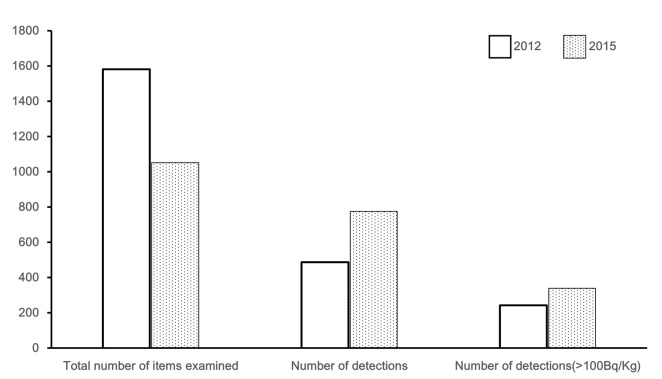
The total number of food items tested for radioactivity, detection item count, and the number of items detected with 100 Bq/kg [regulatory standard value] or more.In 2015, there was a decrease in the total number of tests, but the percentage of radioactive foods was higher than fiscal 2012.